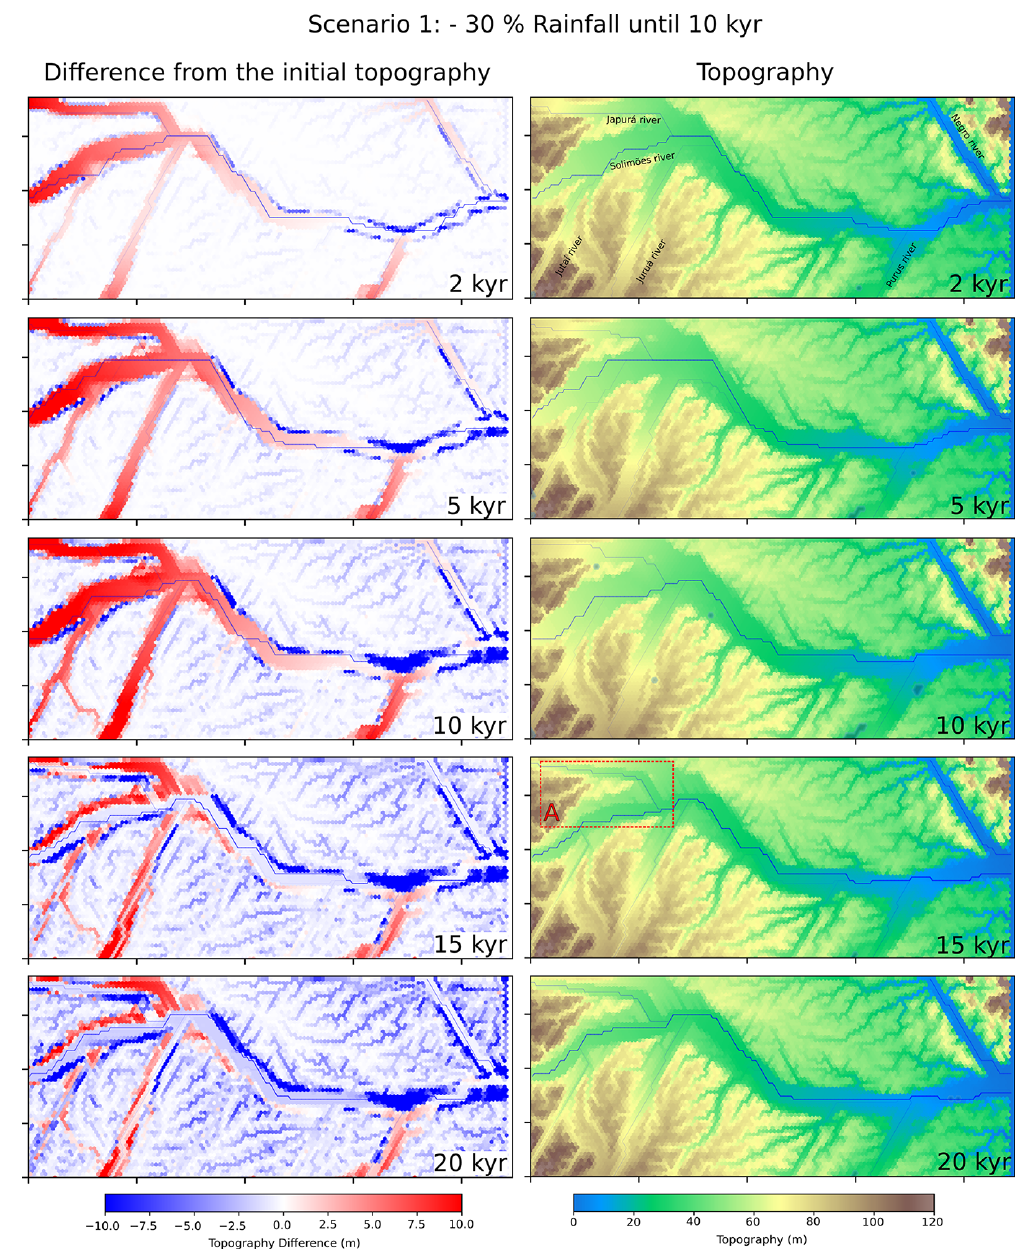
Figure 4. Results of the landscape evolution of scenario 1. The left figures show the difference of the model topography in relation to the initial topography, with colors saturated in red for values in elevation differences higher than 10m and in blue for values below − 10m. The right column shows the model topography itself. The occasional blue stains on the map represent lakes (local minima). Location A indicates new terrace levels being formed around the Japurá